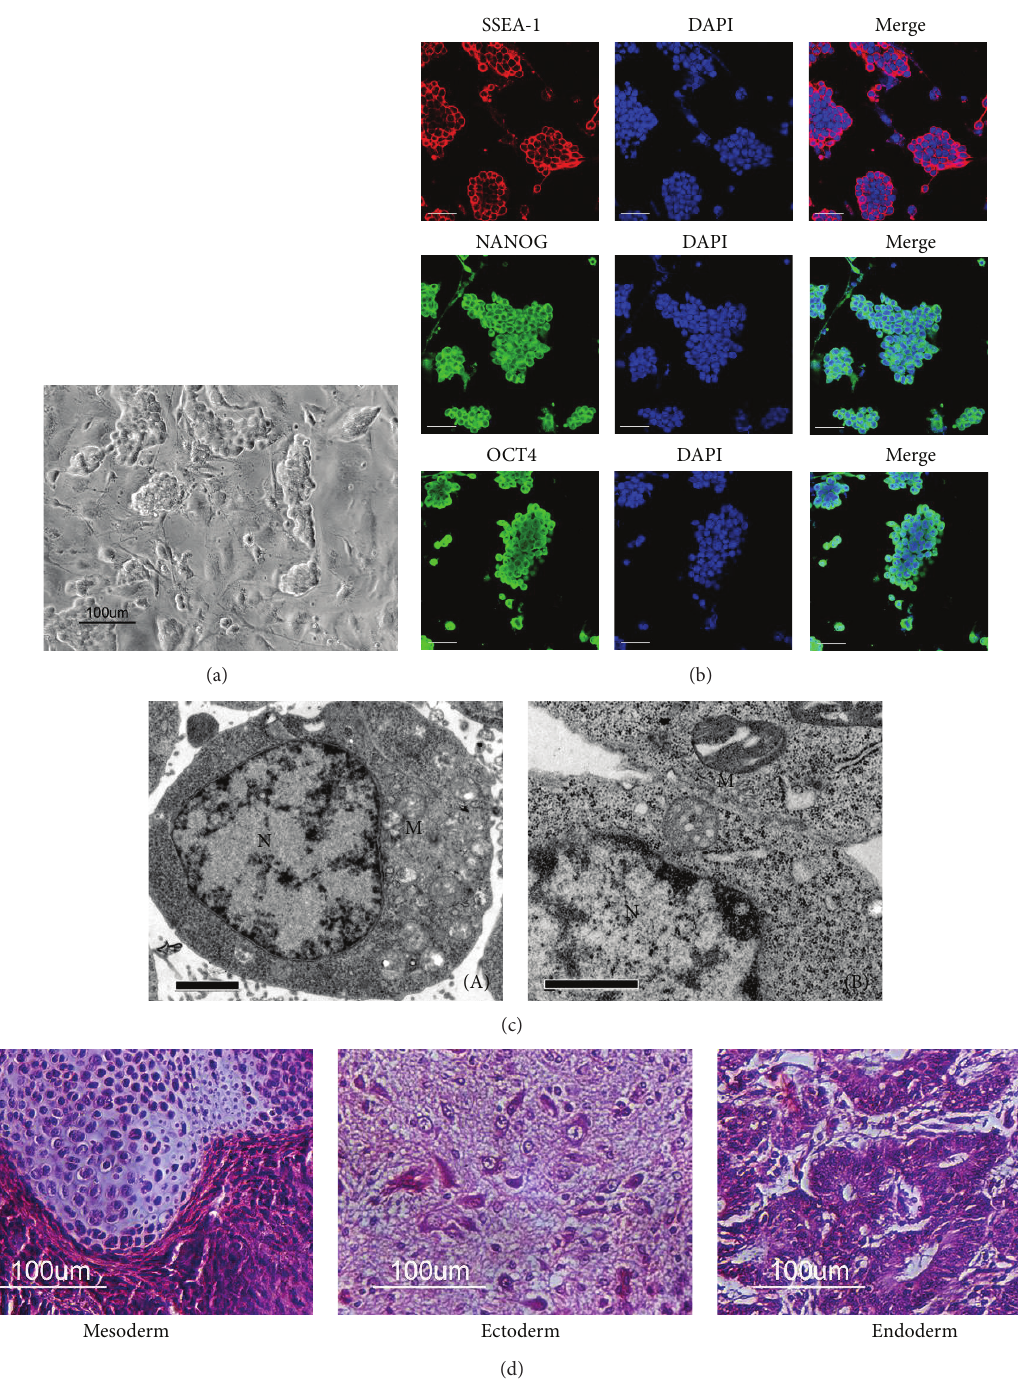
Figure 1: (a) Morphological observations of pESCs under phase contrast microscopy. (b) Immunocytochemistry staining of embryonic stem cell markers for pESCs (bars = 100 𝜇 m). (c) Transmission electron microscopy shows the initial-stage of pESCs (p35), (A), (B): pESCs “N”: nucleus of cell; “M”: mitochondrion; bars = 2 𝜇 m, 1 𝜇 m. (d) H&E staining of teratoma sections from the pESCs. The staining revealed pESCs possessing the capacity to generate cartilage, neurocytes, and gastrointestinal tissue in vivo